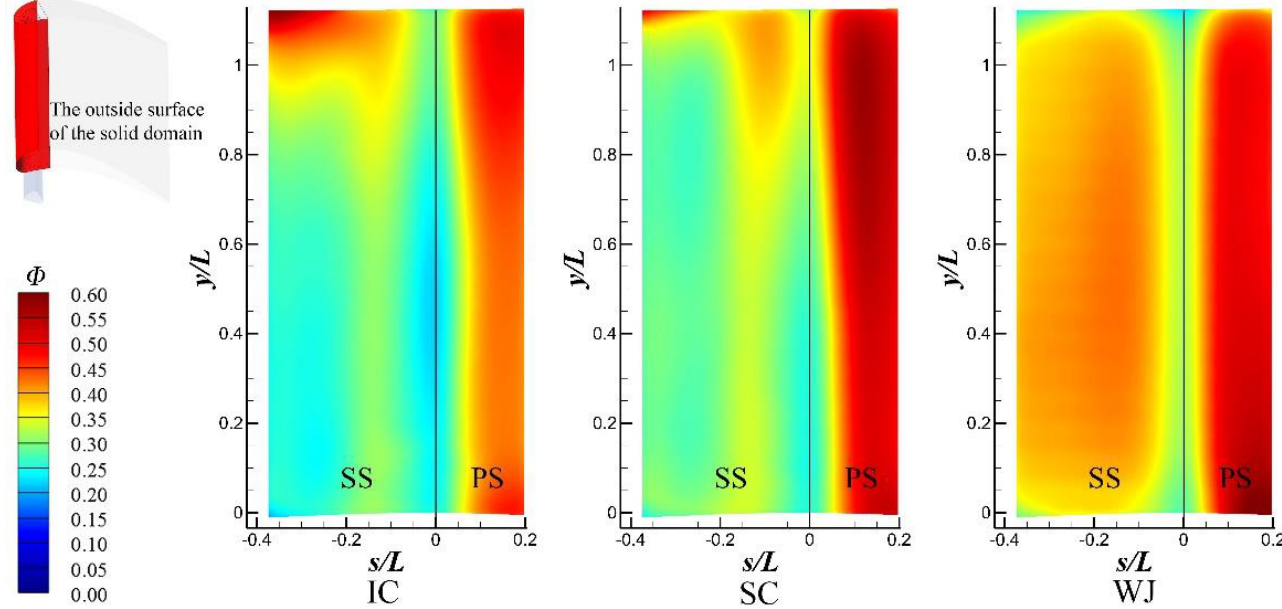
Figure 18. Overall cooling effectiveness distribution of different internal cooling structures ( Re j = 20,000).